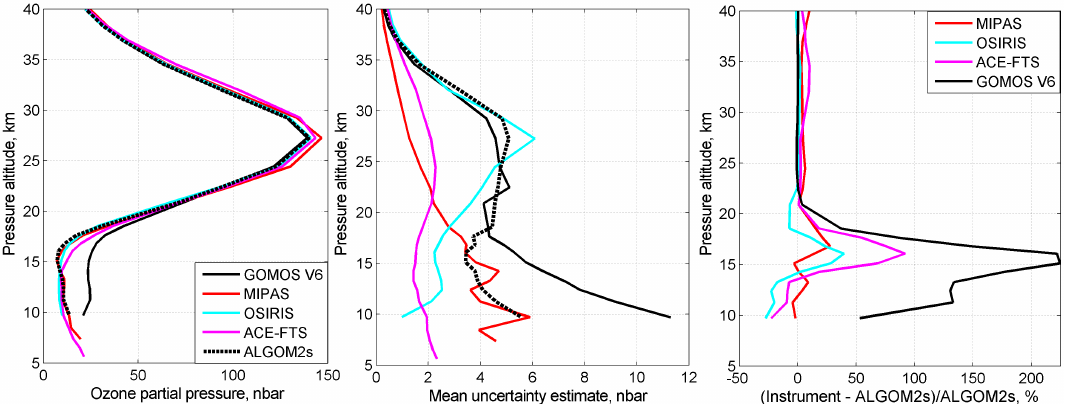
Figure 13. Left: mean ozone profiles at 20 ◦ S–20 ◦ N in 2007–2008 for GOMOS V6, MIPAS, OSIRIS, ACE-FTS, and the ALGOM2s GOMOS processor. Center: mean ozone uncertainty estimates for each instrument in nbar. Right: mean relative difference of ozone profiles with respect to ALGOM2s (Instrument-ALGOM2s/ALGOM2s) in